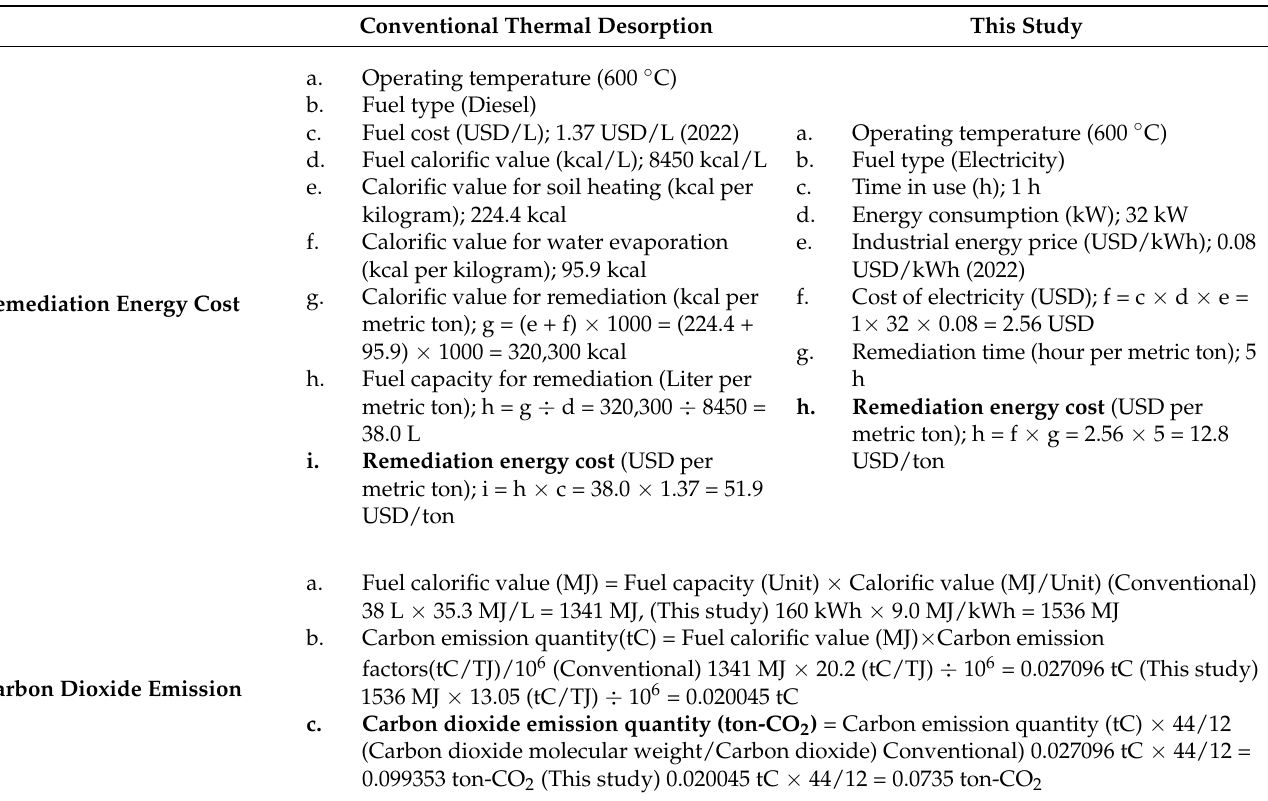
Table A3. Calculation of remediation energy cost and carbon dioxide